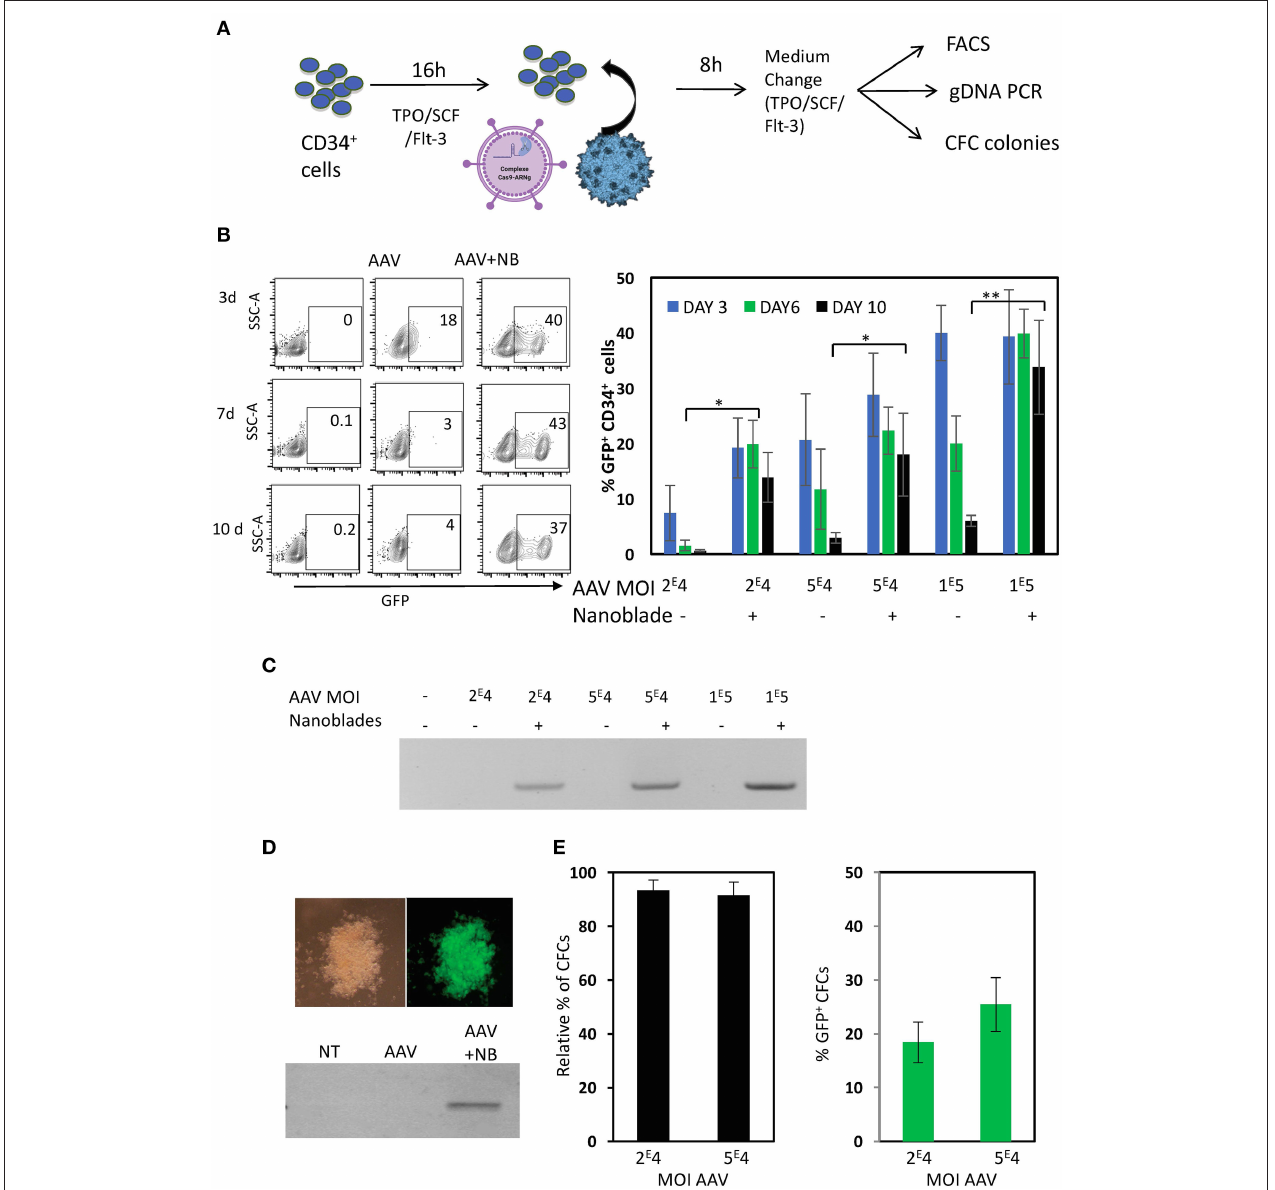
FIGURE 7 | Nanoblades confer knock-in in human CD34 + cells when combined with rAAV6 coding for the DNA donor cassette. (A) Schematic presentation of protocol used for CD34 + cells. CD34 + cells were pre-activated for 72h with cytokines (TPO/SCF/Flt-3), then rAAV6 vector carrying the donor alone or combined with nanoblades were added and DNA extraction was performed after 24h incubation, while flow cytometry analysis was performed on day 3, 6, and 10. CFC colonies were seeded after 24h incubation with rAAV6 or rAAV6 + nanoblades and CFC colonies were counted and screened at 14 days for GFP expressing by flow cytometry. (B) A representative flow cytometry plot for GFP + CD34 + cell is shown for day 3, 6, and 10 post-treatment with rAAV (MOI = 1 × 10 5 ) or rAAV + nanoblades (left). A summary of the results is shown in the graph on the right (means ± SD; n = 4; four independent CD34 + cell donors; student t -test, * p < 0.05, ** p < 0.01). MOIs for rAAV are indicated. (C) Genomic DNA at day 10 post-treatment was isolated and integration was determined by PCR using WAS-Fw and GFP-Rv in Figure 6A . Data are representative of n = 4. (D) At 24h post-treatment CD34 + cells were differentiated into myeloid colonies. At day 14 of differentiation into CFC colonies, colonies were screened for GPF expression and genomic DNA was isolated and integration was determined by PCR using WAS-Fw and GFP-Rv. Data are representative of n = 3. (E) Relative % of number of colonies for nanoblades + rAAV6 treated CD34 + cells compared to untreated CD34 + cells and % of GFP + at day 14 of differentiation. MOIs for rAAV6 are